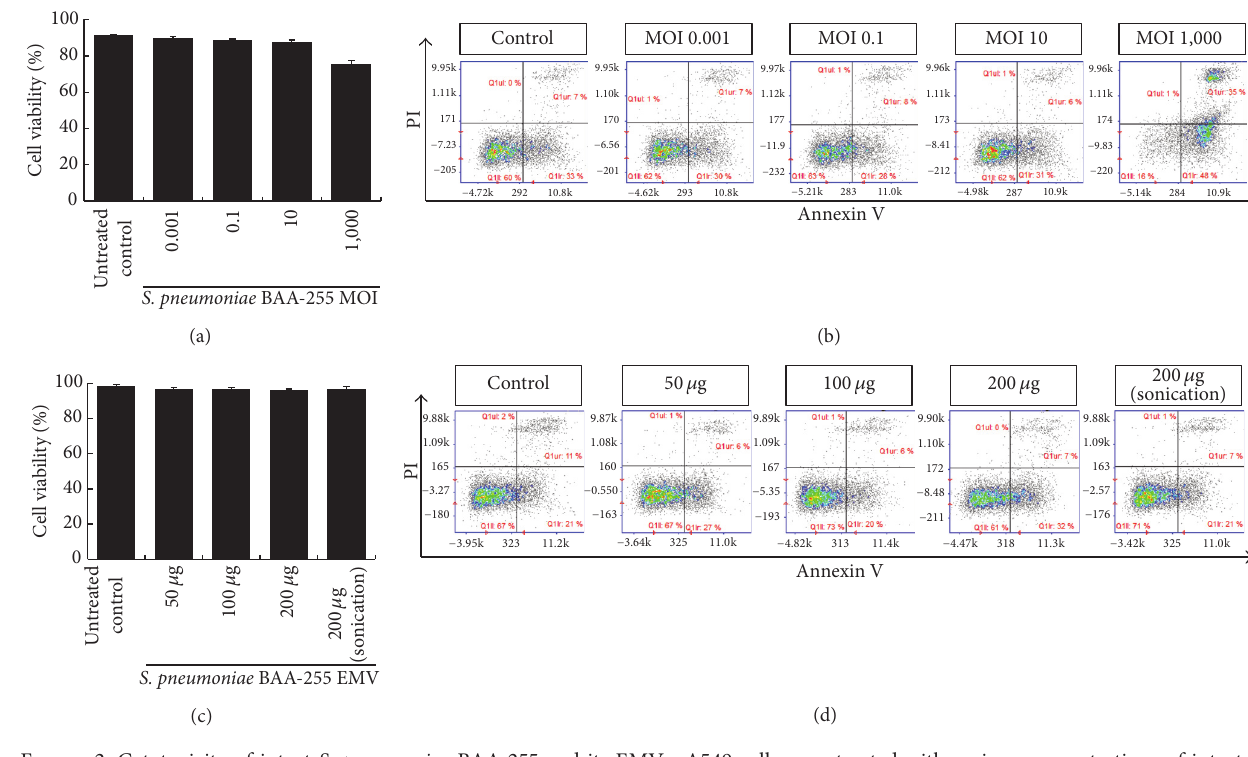
Figure 2: Cytotoxicity of intact S. pneumoniae BAA-255 and its EMVs. A549 cells were treated with various concentrations of intact S. pneumoniae BAA-255 and cell viability (a) and apoptosis (b) were analyzed. A549 cells treated with various concentrations of S. pneumoniae BAA-255 EMVs and cell viability (c) and apoptosis (d) were